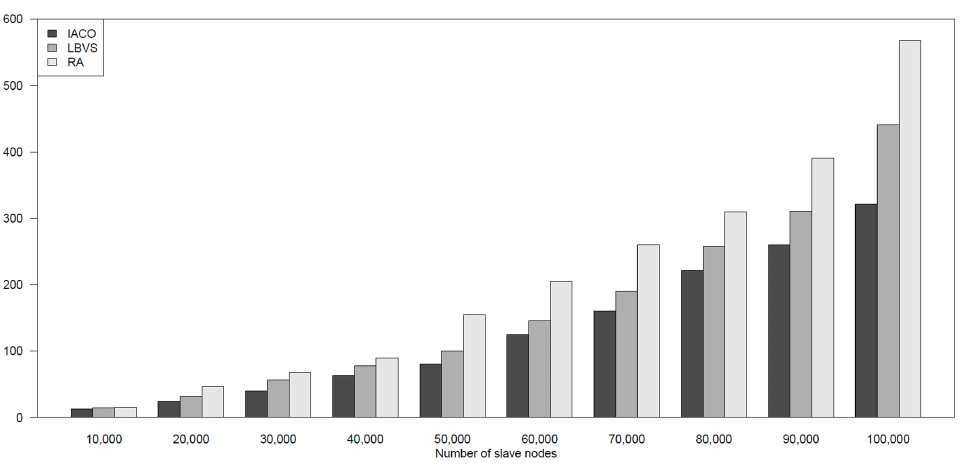
Figure 8. Execution time for load balancing by different